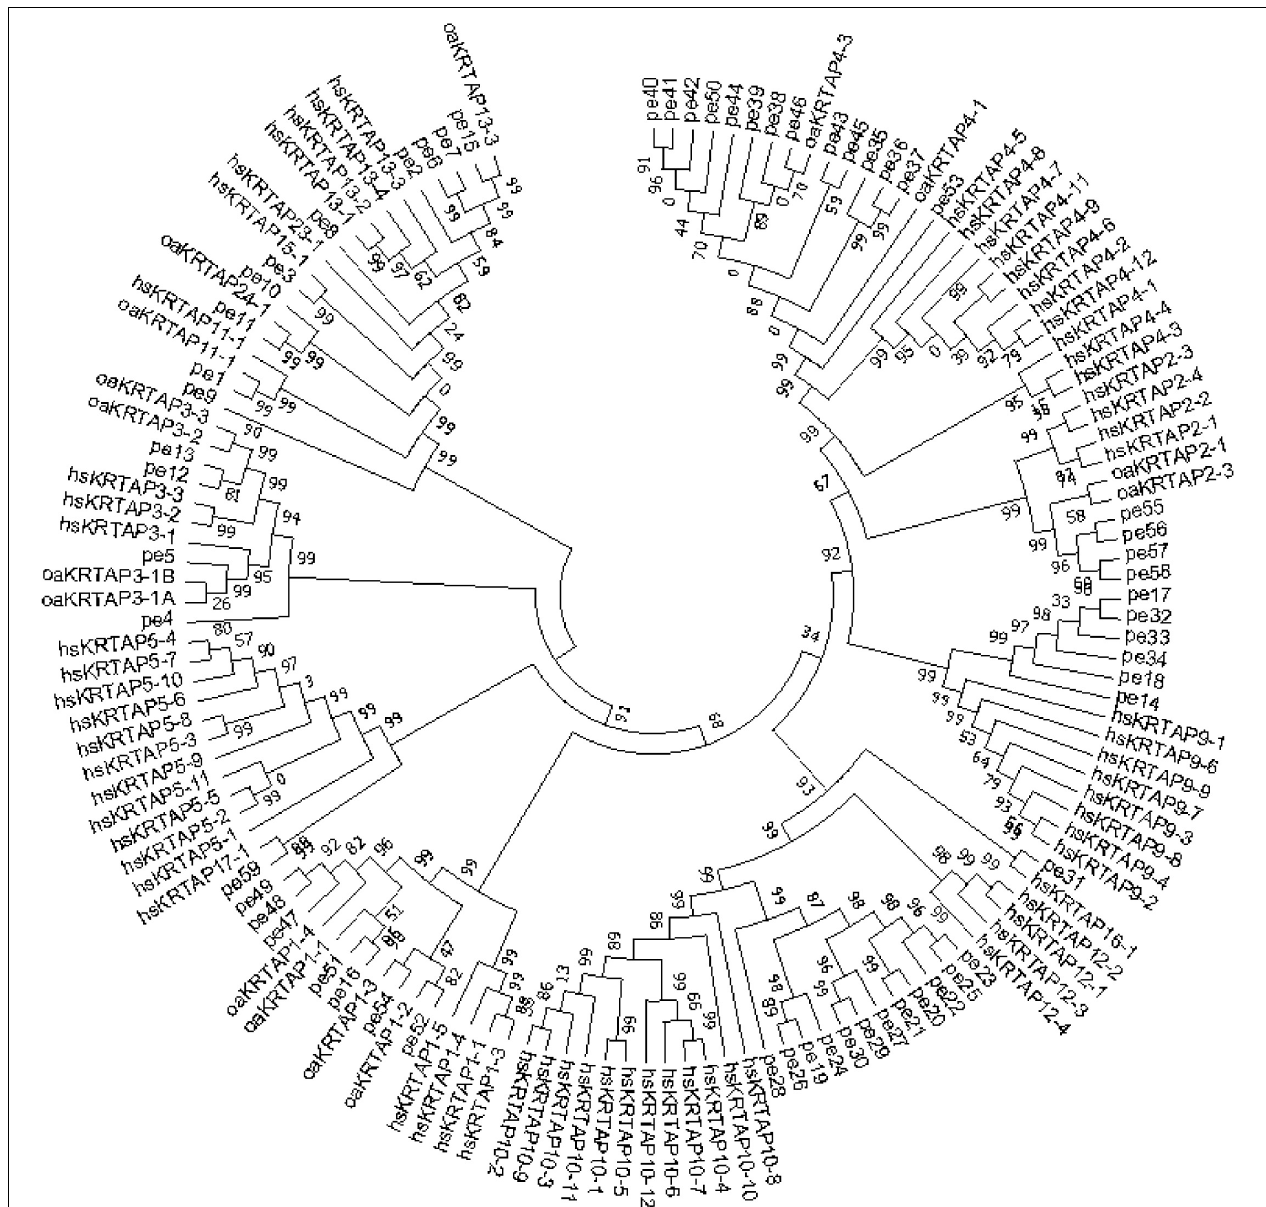
FIGURE 2 | Phylogenetic tree of human, sheep, and goat high-sulfur proteins. The prefixes pe, oa, and hs indicate goat, sheep, and human,